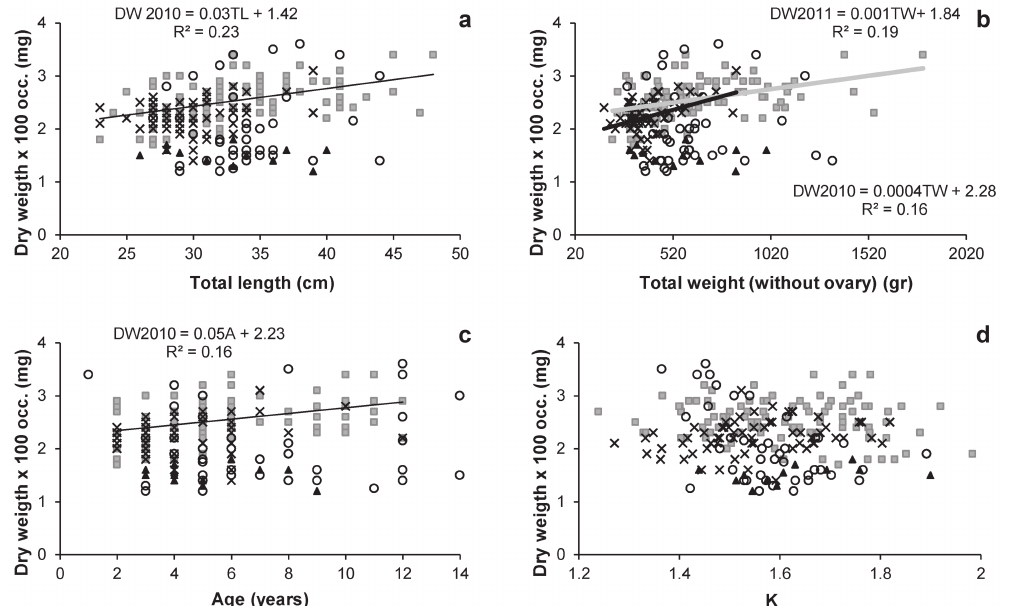
Fig. 5. Relationships between oocyte dry weight and: ( a ) total length; ( b ) total weight (without ovary); ( c ) age in years; and ( d ) condition factor for Pagrus pagrus . Gray squares: 2010; cross: 2011; black triangles: 2012 and circles: 2013.Gray line: 2010 and black line: